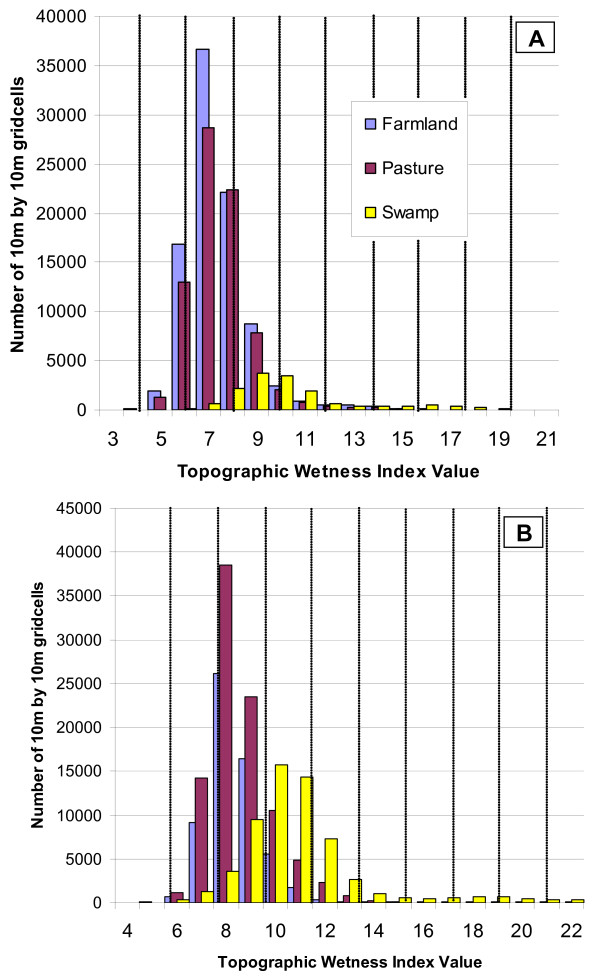
Predicted wetness of categorized land-cover. The predicted wetness of farmland, pasture, and swamp within (a) Kipsamoite and (b) Kapsisiywa, represented by the number of 10 m2 grid-cells. Vertical lines mark the divisions between each of the ten wetness categories used in analysis.